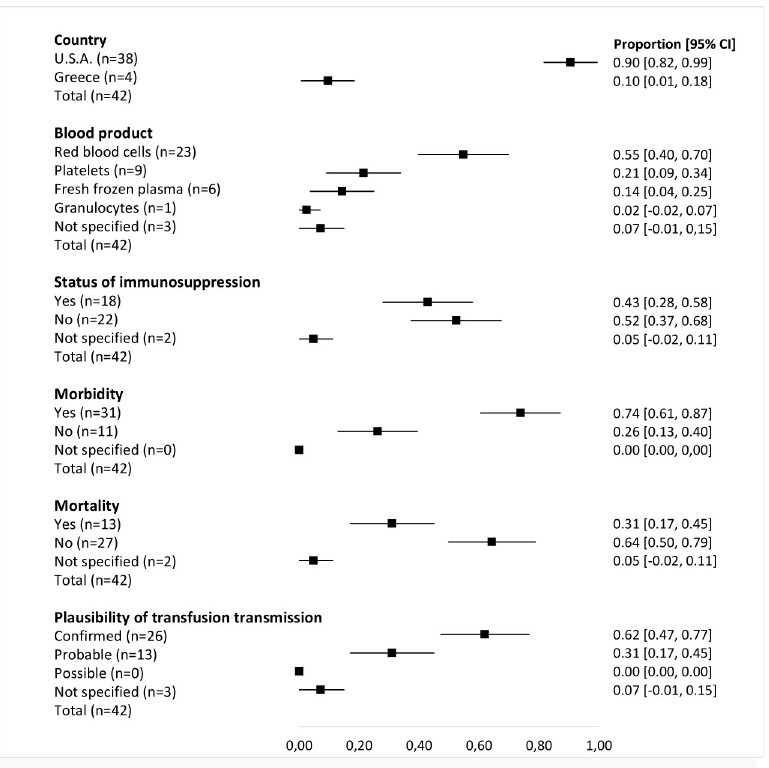
Fig 4. Main reported clinical and epidemiological characteristics of transfusion-transmitted West Nile